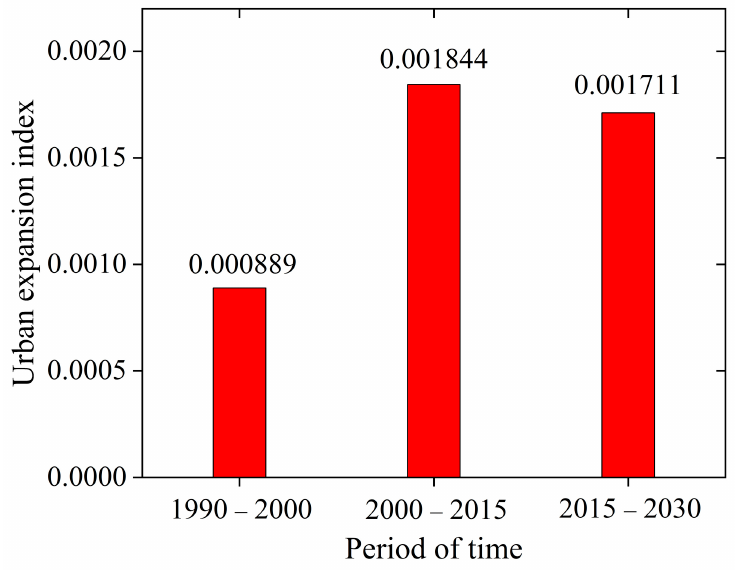
Figure 8. Urban expansion index from 1990–2000, 2000–2015, and 2015–2030.